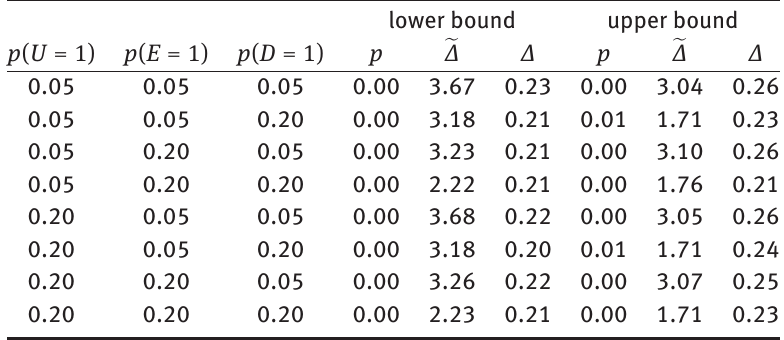
Table F3: Simulation results with σ = 1 . p is the proportion of times that the assumption-free bound was sharper than DV’s (cid:2) Δ are the mean absolute distance between the log of the bound and the log of the true causal risk ratio, for DV’s bound; Δ and bounds and the assumption-free bounds, respectively.